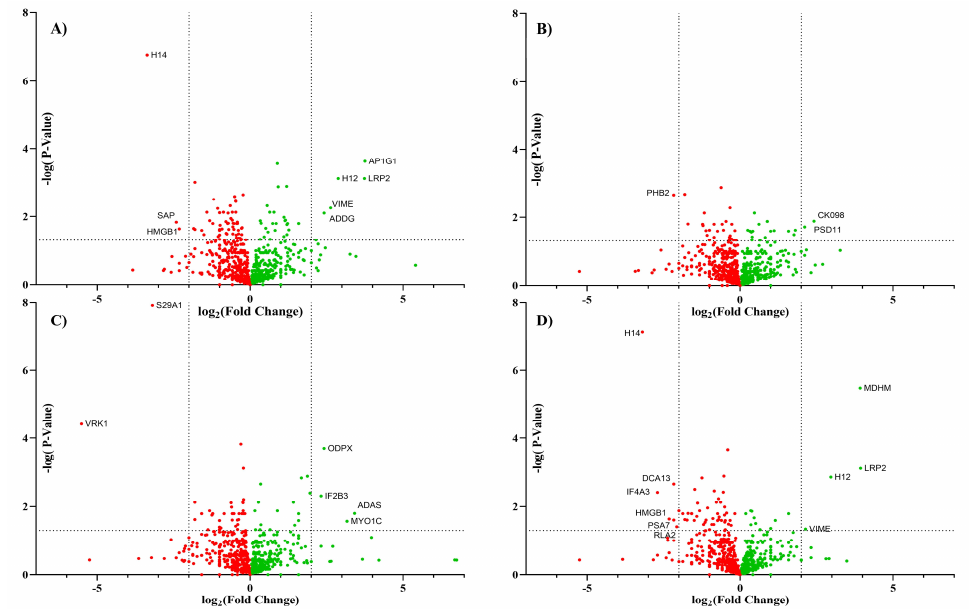
Figure 5. The volcano plot represents the proteomic data from Caco-2 comparing control to an inhibition treatment including ( A ) Kif, ( B ) 3FS, ( C ) 2FF, and ( D ) 6AF. Each data point represents a protein with the downregulation (red) and upregulation (green).